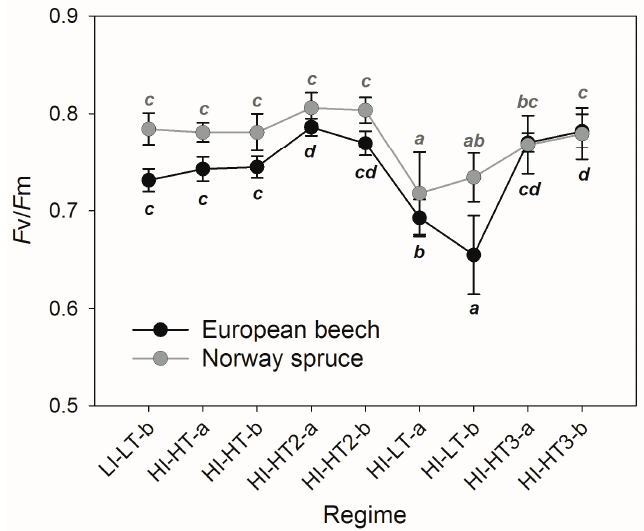
Figure 4. Changes in maximum quantum yield of photosystem II photochemistry ( F v / F m ) measured on dark-adapted leaves and needles at predawn in response to five consecutive regimes of photosynthetically active radiation (PAR) intensity and temperature (LI–LT, HI–HT, HI–HT2, HI–LT, and HI–HT3). Lowercase letters in the regime labels indicate data from measurements at the beginning (a) and end (b) of acclimation to the given regime. Means (points) and standard deviations (error bars) of the measurements on European beech (black points) and Norway spruce (grey points) are presented ( n = 6). Letters above (spruce) and below (beech) the error bars indicate homogeneous groups ( p < 0.05; Tukey’s post hoc test) within individual tree species. Different letters represent statistically significant differences between means.